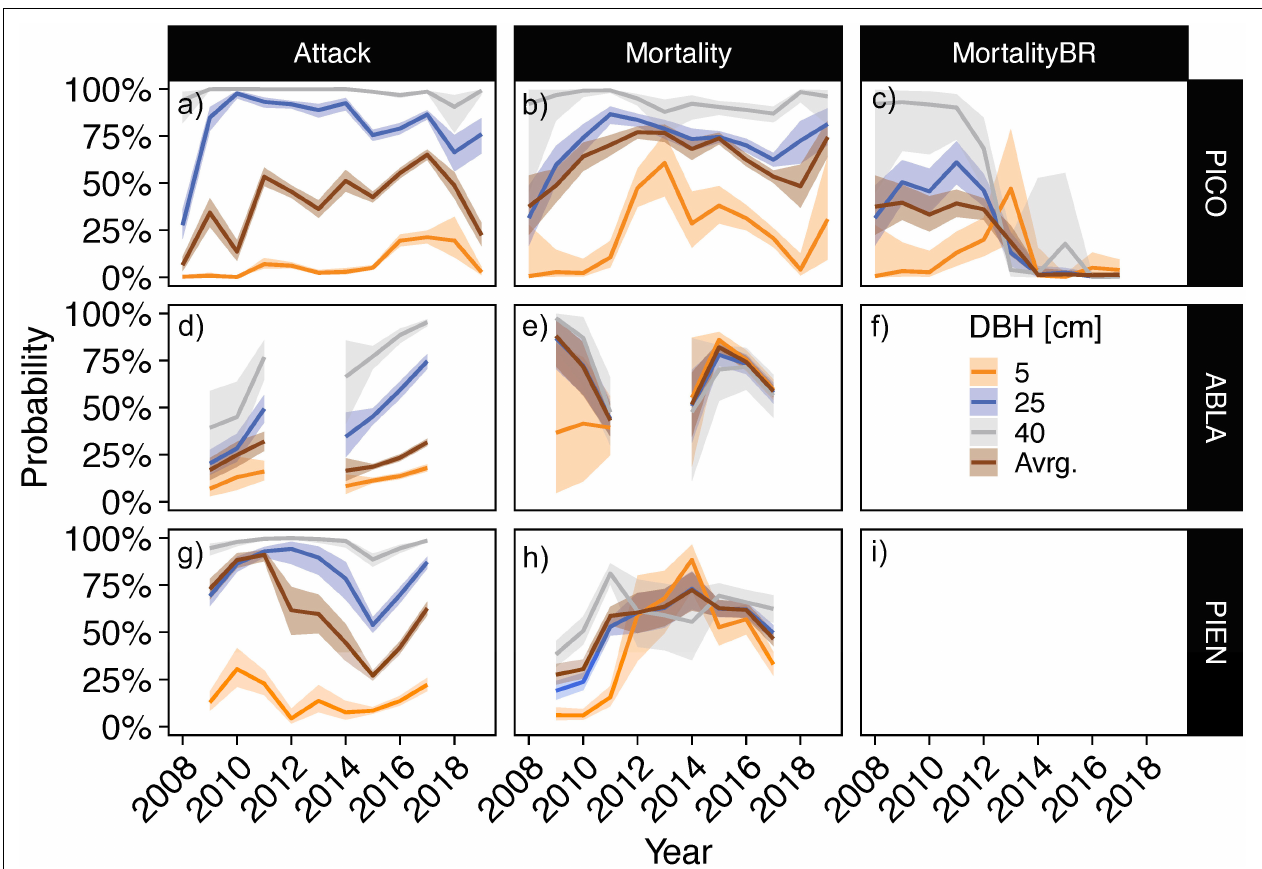
FIGURE 7 | Predicted probabilities of beetle attack (a,d,g) and post-attack mortality (b,e,h) in each sampled year for hypothetical trees with 5, 25, or 40 cm diameter at breast height (DBH). Values were based approximately on the 0.05 and 0.95 quantile of all sampled tree sizes in this study, with 5 cm repesenting the lower bound for all species, 25 cm repesenting the upper bound for lodgepole pine, and 40 the upper bound for subalpine fir and Engelmann spruce. “Avrg.” represents the predicted probabilities for a live tree of average DBH in that year (see Supplementary Figure 17 for annual DBH averages). For lodgepole pine, year-to-year mortality was also modeled [i.e., “MortalityBR”; (c,f,i) ]. Lines represent posterior medians and bands represent the 94% credible intervals. The model was not run for year-to-year probabilities of mortality for subalpine fir and Engelmann spruce (no reliable data of year-to-year change), and from 2012 to 2013 for subalpine fir (not enough samples). PICO: lodgepole pine (a–c) ; ABLA: subalpine fir (d–f) ; PIEN: Engelmann spruce (g–i)